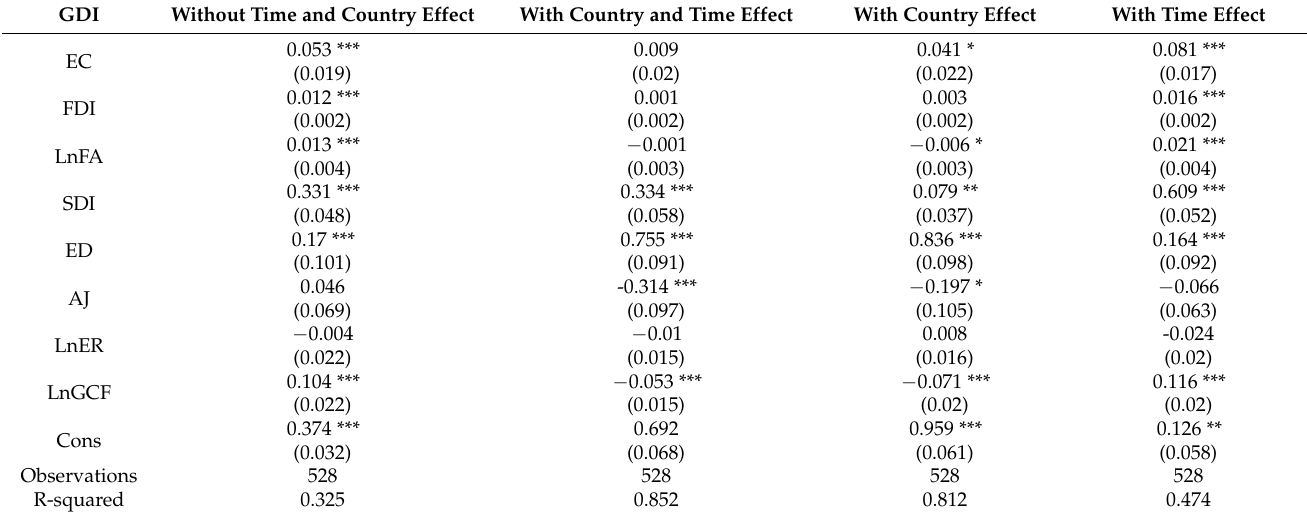
Table 2. Results of Simple Linear Regression 2000 − 2020 for 24 Asian countries. Dependent variable: Gender Development Index (United Nations